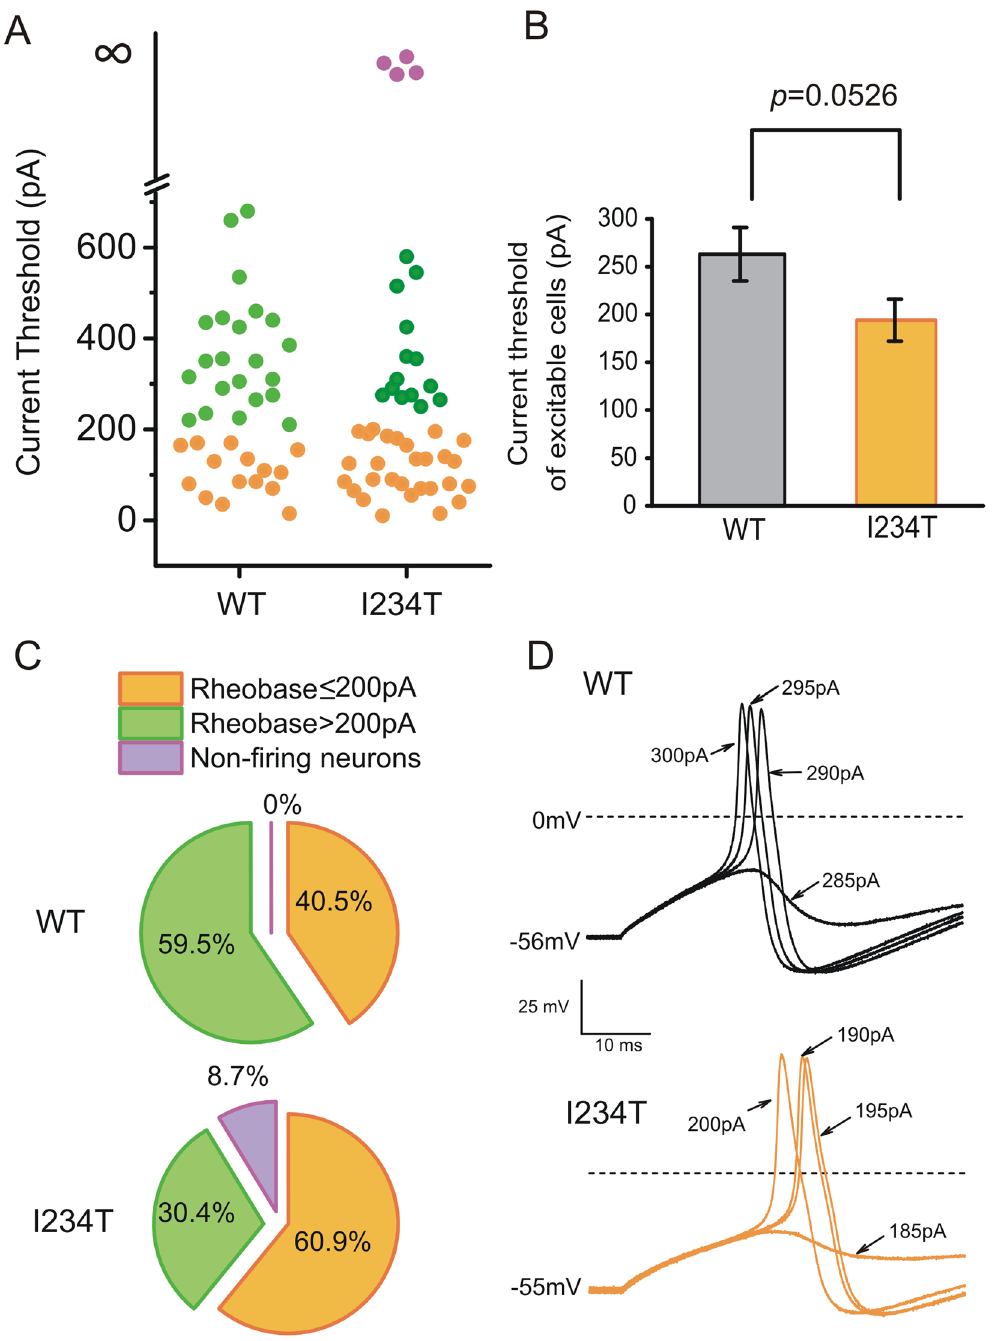
Figure 2. Expression of I234T tends to lower current threshold in DRG neurons that are excitable at native resting potential. ( A ) Scatter-plot of current threshold in neurons expressing either WT or I234T. Filled circles in magenta represent silent cells that did not fire in response to external stimuli from their native resting potentials but regain excitability when held at − 60 mV. Their current thresholds at native potentials were considered infinite. ( B ) In neurons that were excitable at native resting potentials, I234T tended to reduce average current threshold, compared to WT. ( C ) Populations of cells with current thresholds ≤ 200 pA (orange), > 200 pA (green) and silent (magenta) at their native resting potentials. ( D ) Representative responses of neurons expressing WT or I234T to 200 ms current injections in 5 pA increments. The cell expressing WT had an RMP of − 56 mV and a current threshold of 290 pA (upper). The neuron expressing I234T had an RMP of − 55 mV and generated an action potential at a threshold of 190 pA